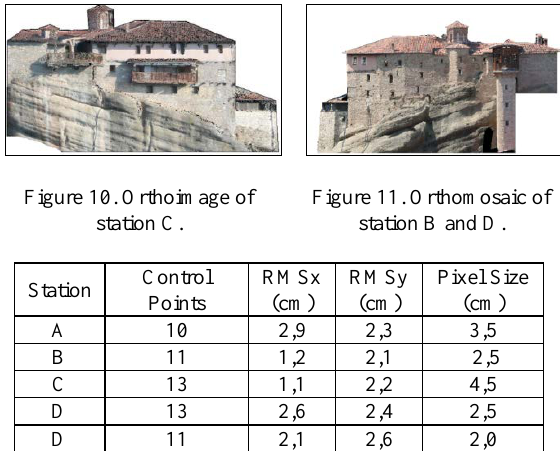
Table 5. Resection Results for Orthoimage